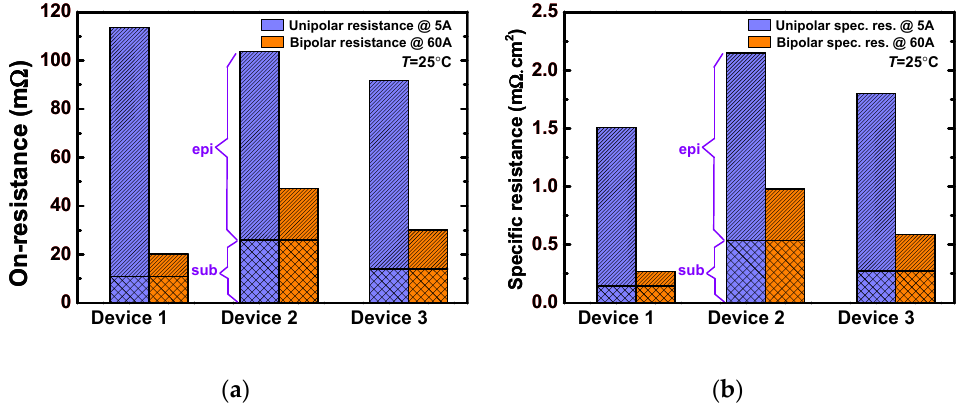
Figure 8. ( a ) The on-resistance ( R on ) and ( b ) the specific on-resistance ( R on,sp ) of the three devices in unipolar mode (5 A) and bipolar mode (60 A) at T = 25 °C, extracted from Figure 3, with the resistance of the epitaxy layer and substrate shown separately.